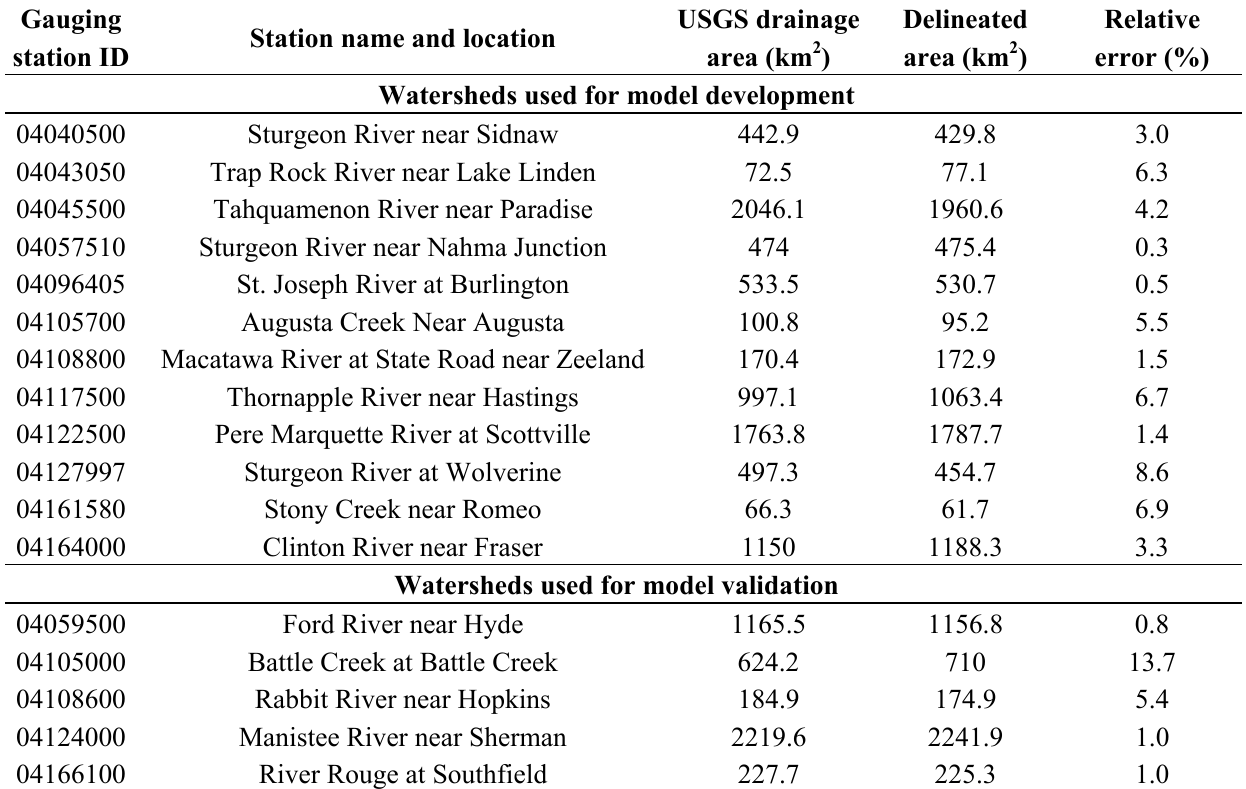
Table 1. Michigan watersheds used for model development and